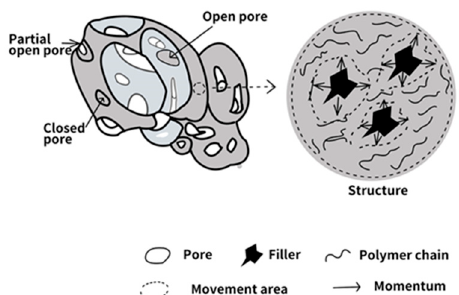
Figure 9. Schematic illustration of mechanical damping e ff ects of TOPUF adding ML powders under sound waves.